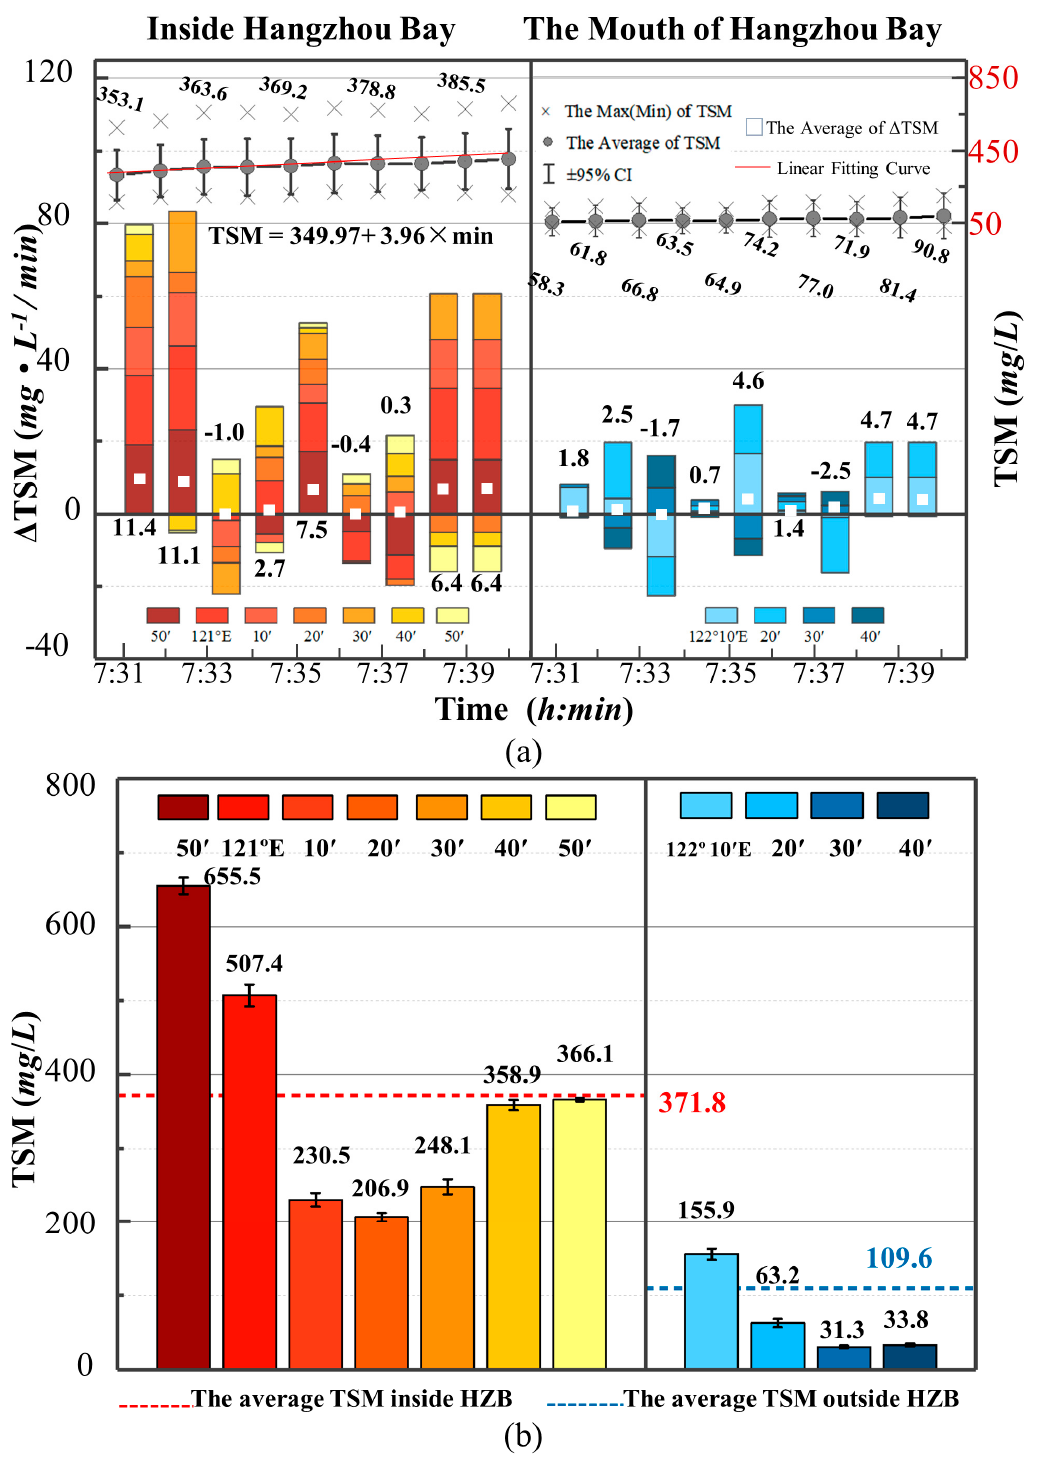
Figure 7. ( a ) The increment of TSM in minute scale. The left side is the situation inside HZB, and the right-hand side is outside HZB. The box-whisker plot is the average TSM per minute. The histogram plot is the TSM change between two box-whisker plots, which is a superposition of the TSM change in different transects. The white small rectangle represents the average change of TSM, and the value is marked under the histogram plot. ( b ) The mean TSM concentration at different transects in HZB, including seven transects inside HZB and four transects outside HZB. The red and blue dotted lines are chosen to represent the average TSM concentration inside and outside HZB, respectively.